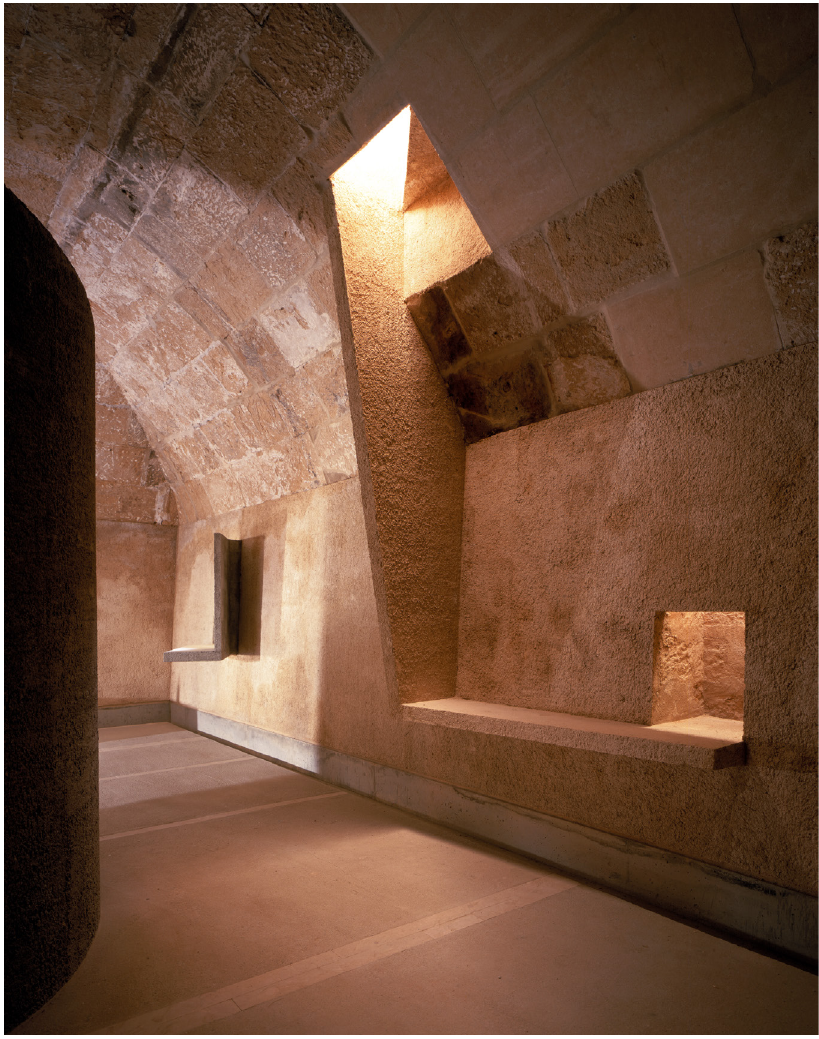
Figure 4. Flores Prats, Mills Museum. Palma de Majorca, 1999–2002. Detail of light modulation through external masonry walls and integration with recesses and ledges for display. Photograph by Hisao